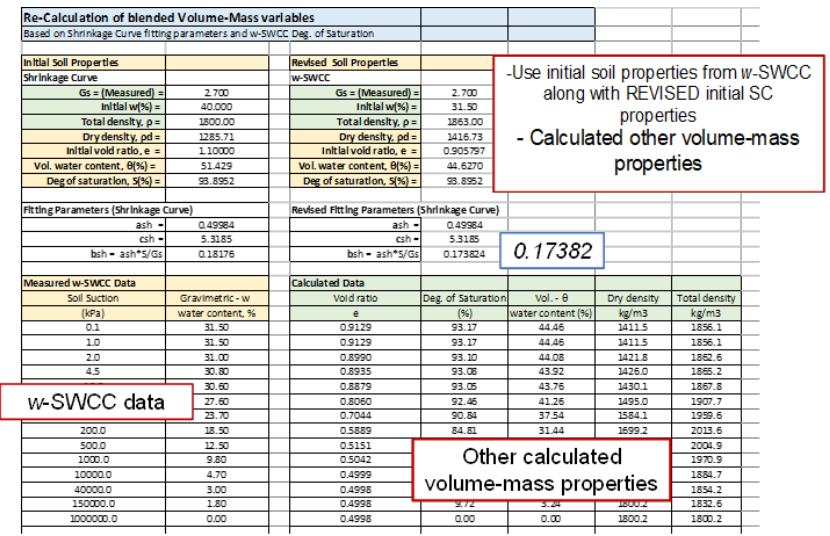
Figure 13. Calculation of other volume-mass variables corresponding to the dataset measured in the SC and w-SWCC